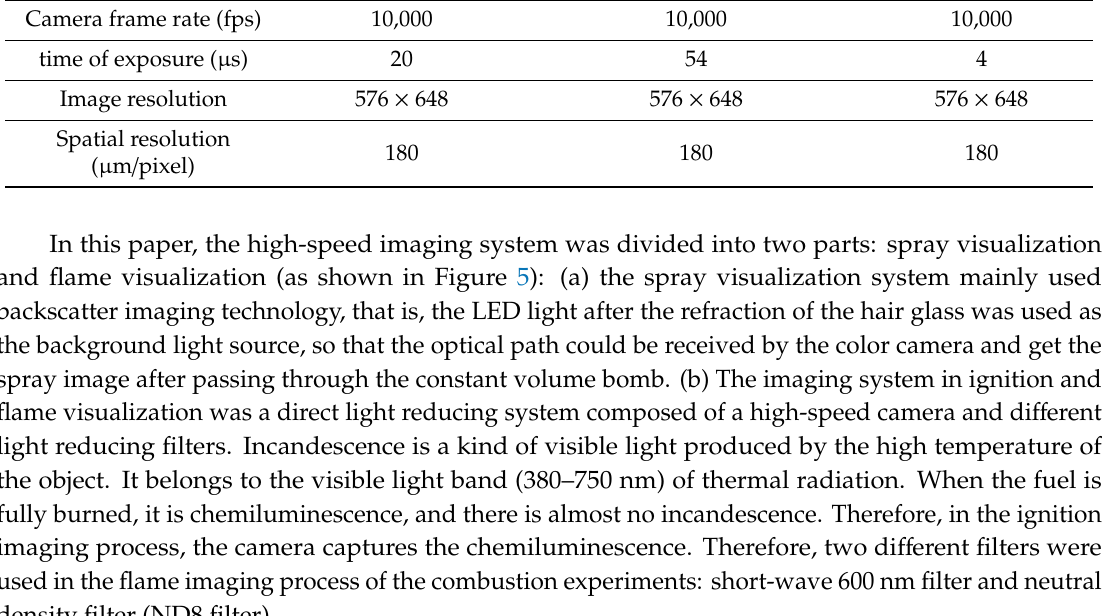
Table 1. Imaging conditions.